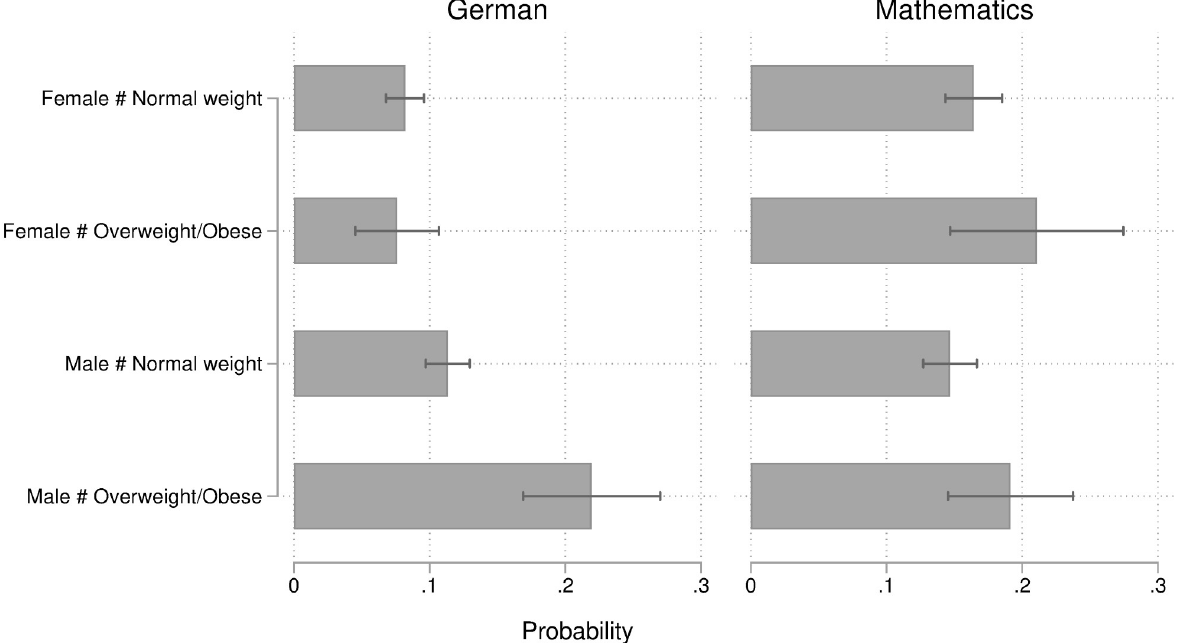
Fig 4. Predicted probabilities of obtaining a low grade by BMI and gender. Predicted probabilities (and 95% confidence intervals) derived from hierarchical ordinal logistic regression models of teachers’ grading in German (left graph) and mathematics (right graph), adjusted for students’ competence level, socio-demographic characteristics, psychological traits, and school-related attitudes and behavior. N = 3,754. Analysis conducted on 50 multiply imputed datasets.